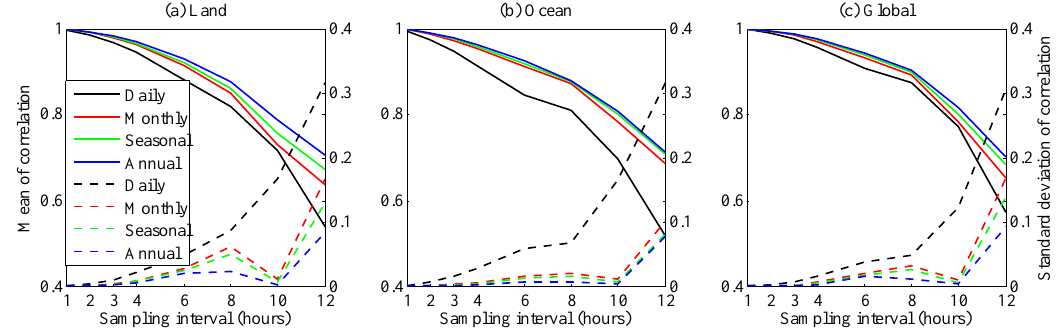
Figure 10. The mean of the correlation coefficients R n (solid curves) and the standard deviation of the correlation coefficients σ R , n (dashed curves) for ( a ) land; ( b ) ocean; and ( c ) global regions. The axis on the left of the panels shows the mean values, and the right axis shows the standard deviation